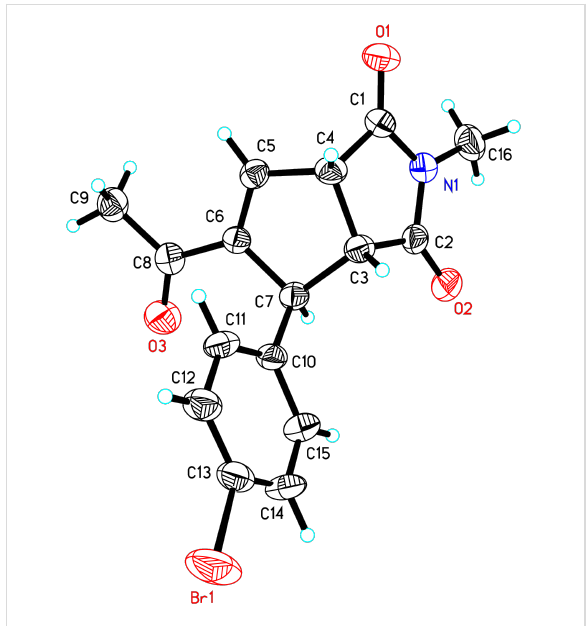
Figure 1: The ORTEP plot of compound 3r